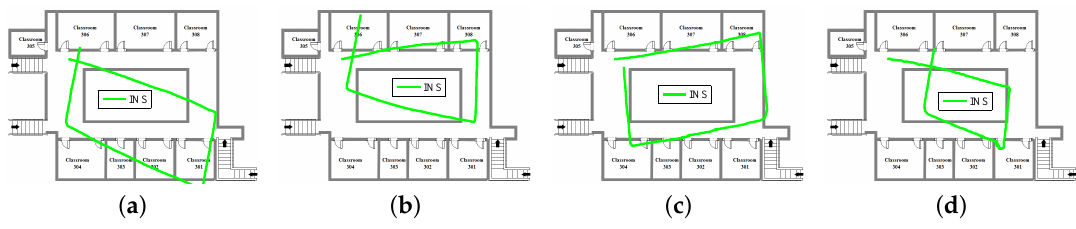
Figure 5. Positioning results for INS: ( a ) calling; ( b ) dangling; ( c ) handheld; and ( d )